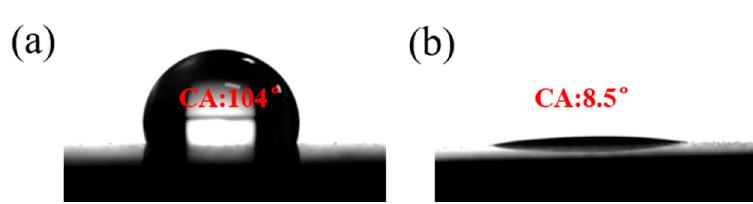
Figure 10. ( a ) Water CA ( θ w ) on the smooth superhydrophobic surface; ( b ) CA of lubricant ( θ 0 ) on smooth surface modified fluorosilane.